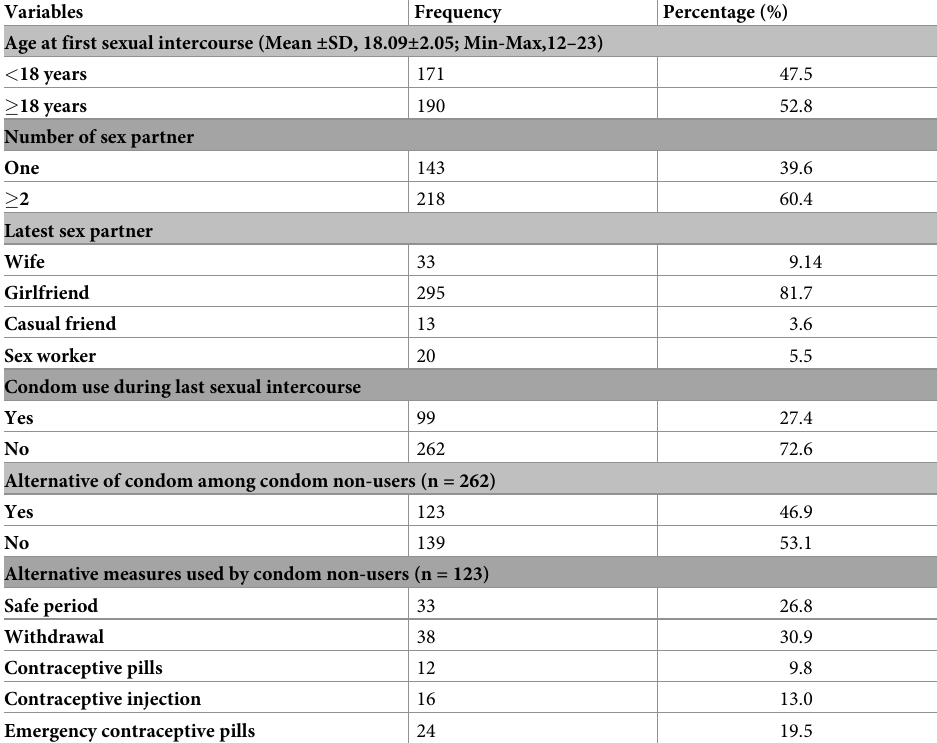
Table 5. Behavioral factors (n = 361).